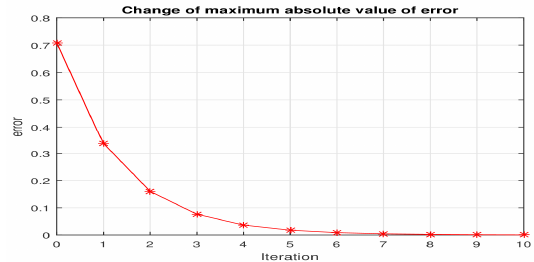
Fig. 13: Tracking Error at Different Iterations using